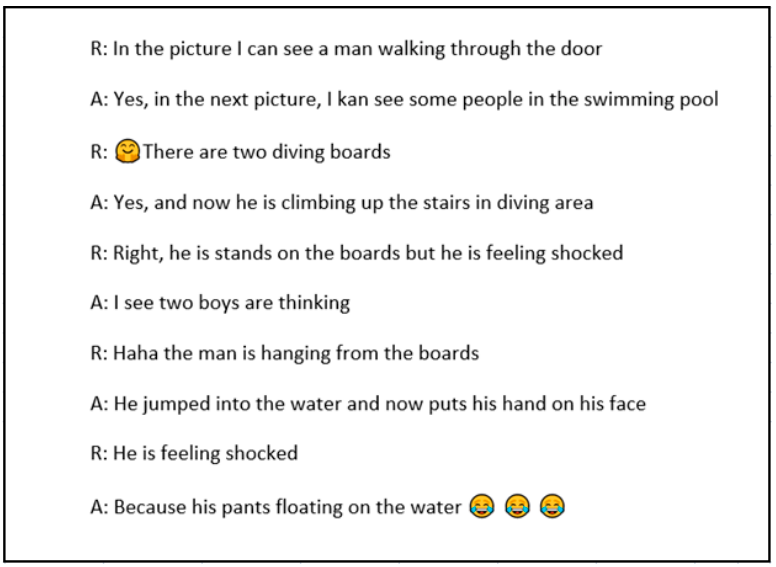
Figure 3. Example of a chat log for treatment task 1.